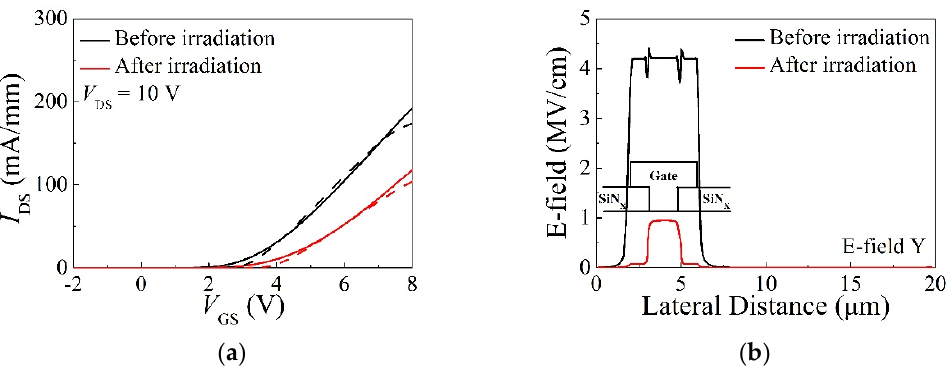
Figure 7. ( a ) The simulated transfer curves (dashed lines) compared with the measured ones (solid lines). ( b ) The vertical electric field distribution of the gate dielectric with V GS = 14 V.